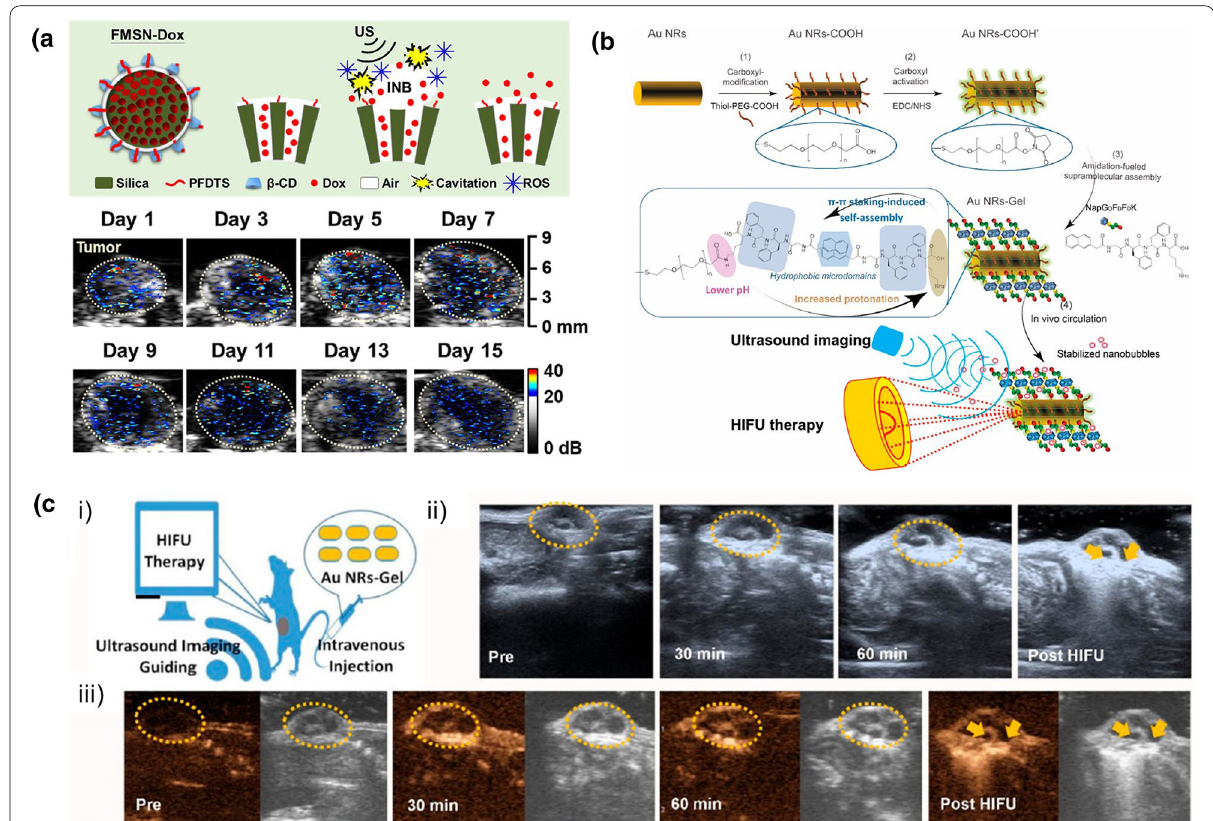
Fig. 7 Examples of GSNs used for in vivo ultrasound imaging. a Schematic showing drug loaded hydrophobic MSNs coated with β-CD (above) and in vivo ultrasound contrast enhancement as a result of cavitation generation by GSNs over 15 days. Adapted from reference [40], Copyright